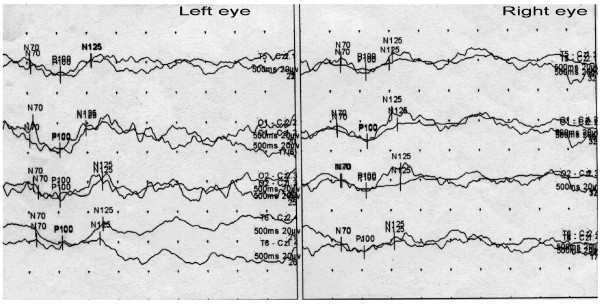
Visual evoked potential on Oct. 22, 2010: Flash stimulation tests were performed on both eyes. The results revealed that the waveforms of both eyes were poorly differentiated, the fundus was slightly wider than normal; P100 amplitude was lower than normal (T6- CZ), but the P100 latency was basically normal.